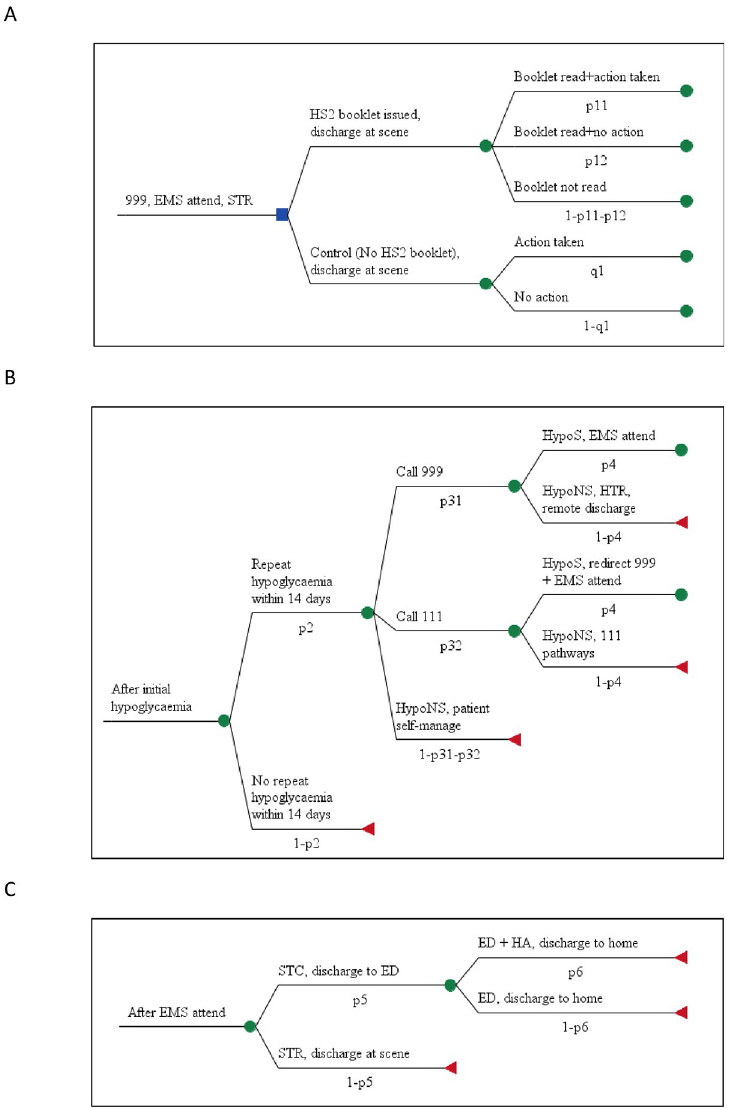
Fig 1. Decision tree structure of the economic model. (A) stage 1: responses to initial hypoglycaemia. (B) stage 2: responses to recurrent hypoglycaemia. (C) stage 3: secondary care outcomes. Full tree formed by mapping stage 3 onto every non-terminating node of stage 2, then that combination mapped onto every stage 1